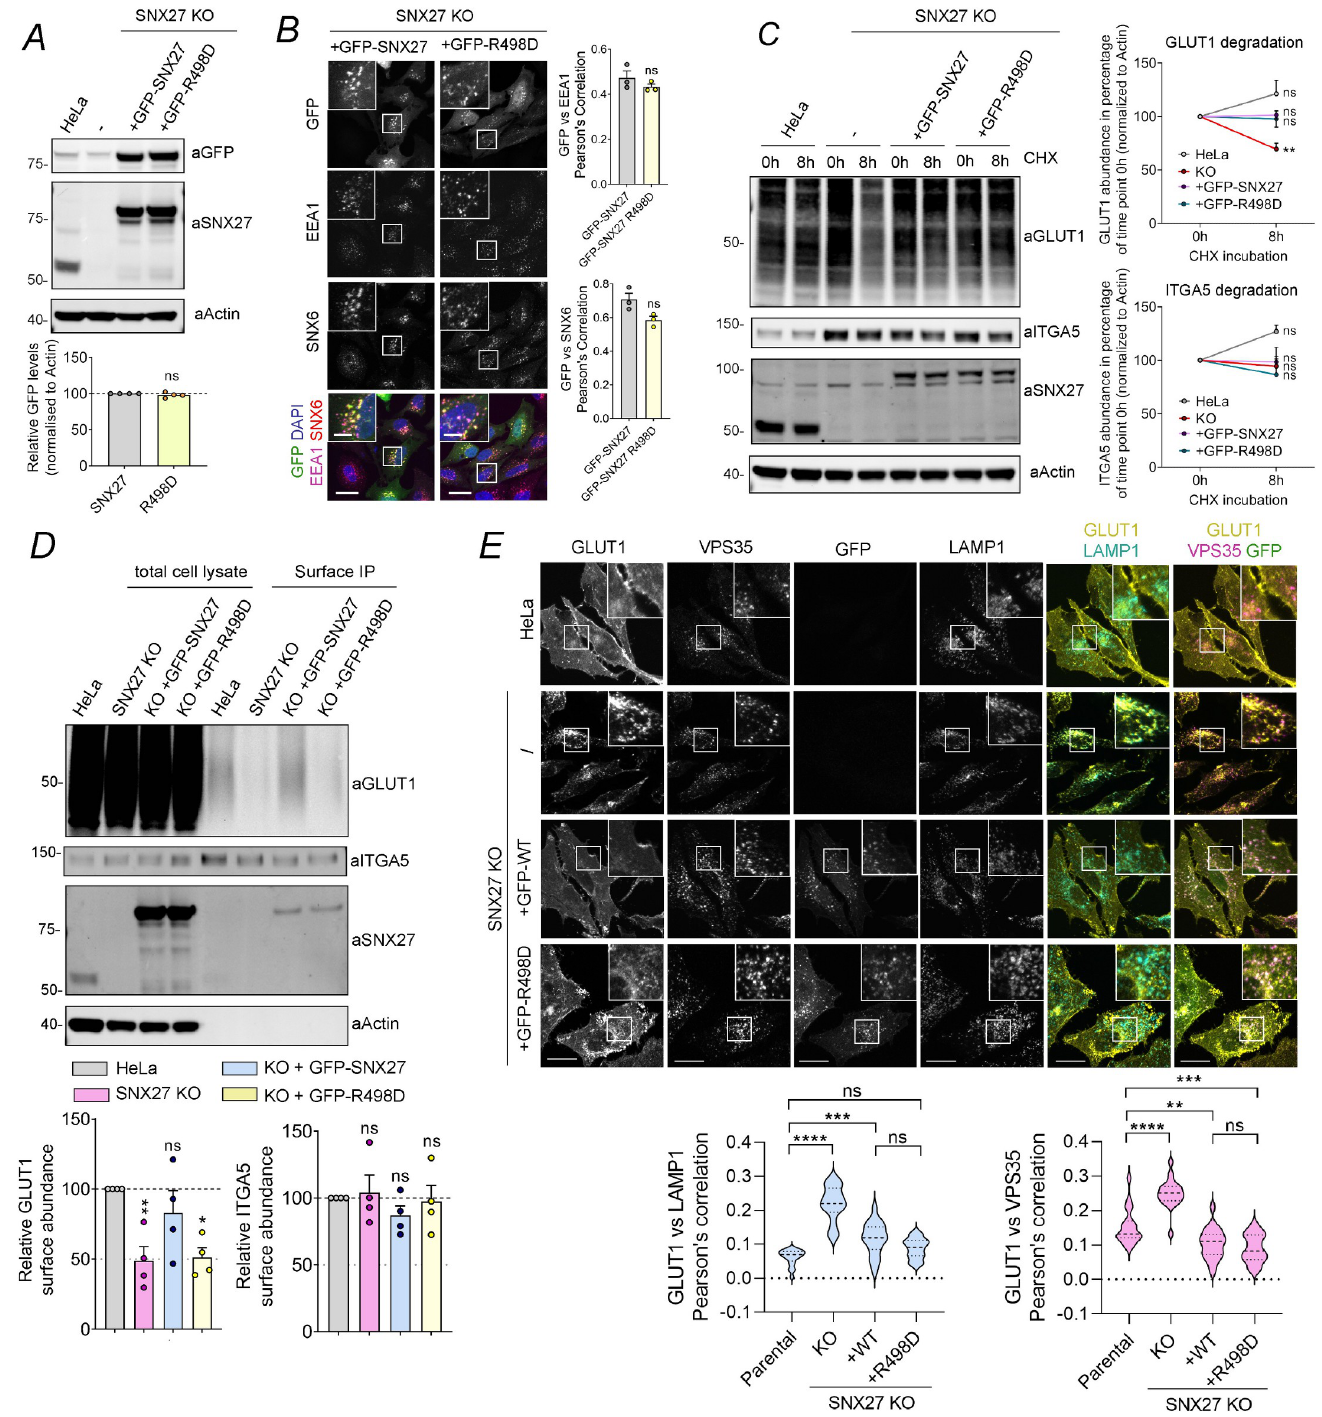
Fig 5. SNX27:ESCPE-1 interaction is required for endosome-to-plasma membrane recycling of SNX27 cargos. (A) Representative western blot showing similar expression levels between transiently expressed GFP-SNX27 and GFP-SNX27(R498D). (B) Representative images of SNX27 KO HeLa cells transiently transfected with GFP-SNX27 or GFP-SNX27(R498D). Moreover, 48 hours after transfection, cells were fixed and immunostained for the endosomal markers EEA1 and SNX6. Magnified views of the white boxes are shown boxed. Cell numbers analyzed for colocalization were 60 GFP–SNX27 and 60 GFP–SNX27 R498D cells across n = 3 independent experiments. The Pearson coefficient values were compared using a 2-tailed unpaired t test; for EEA1 P = 0.2971, SNX6 P = 0.0506. (C) Degradation assay in parental HeLa cells or SNX27 KO HeLa cells that were transiently transfected with GFP-SNX27 or GFP-SNX27(R498D) mutant. Moreover, 48 hours after transfection, cells were incubated with 10 μ g/ml cycloheximide and lysed at different time points as indicated. The band intensities of endogenous GLUT1